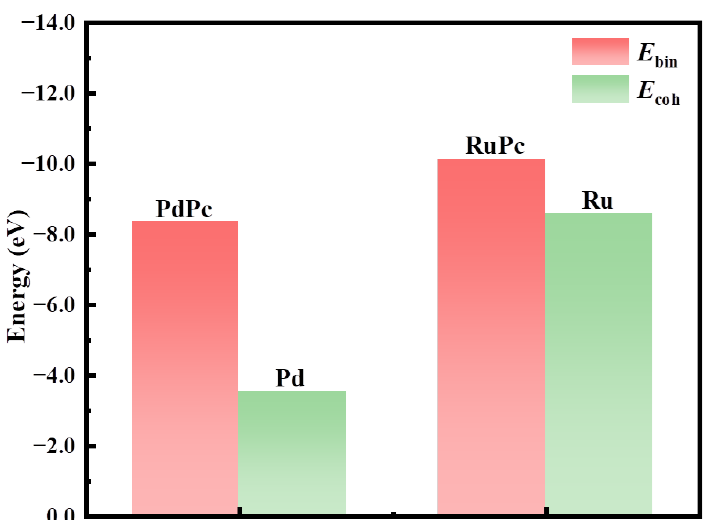
Figure 2. Binding energy ( E bin ) between Pd, Ru, and Pc monolayers and cohesive energy ( E coh ) of Pd and Ru bulk. and Ru